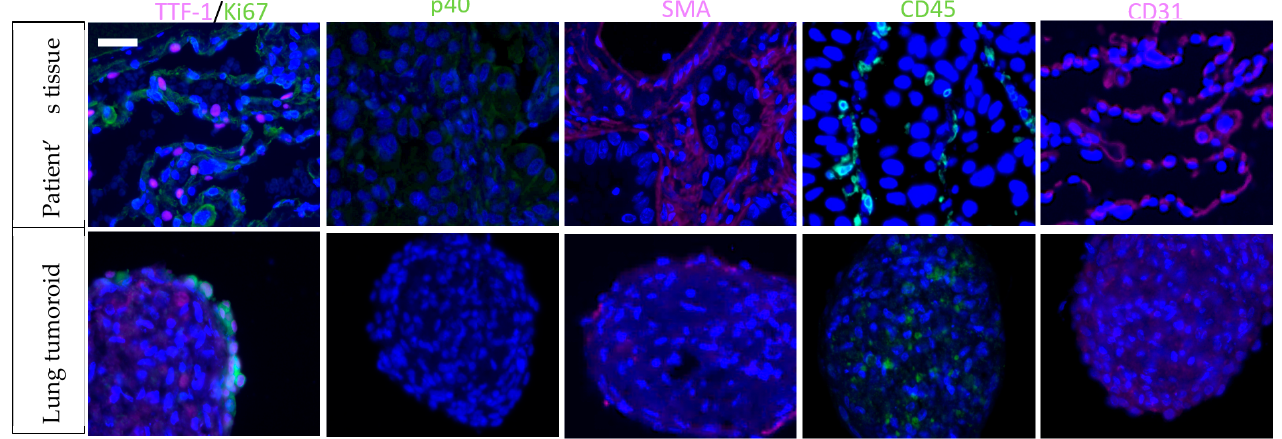
Figure 2. Example of NSCLC tumoroid model and its applications. Tumor samples were obtained from NHC (Nouvel Hôpital Civil) in Strasbourg, France. Washing and enzymatic digestion were performed within 1–2 h after resection. Tumoral cells were centrifuged, and other cell types, such as cancer-associated fibroblasts (CAFs) were added to reconstitute the TME complexity. Tumoroids were grown in a final volume of 200 μ L in ultra-low attachment 96-well plates, forming after 5 days of incubation at 37 °C. This tumoroid model is aimed at being inserted into a microfluidic chip to overcome the limit of the static 3D organoid model. Drug toxicity and efficacy assessment are facilitated to select the best treatment opportunity for each individual patient. Created with BioRender.com.